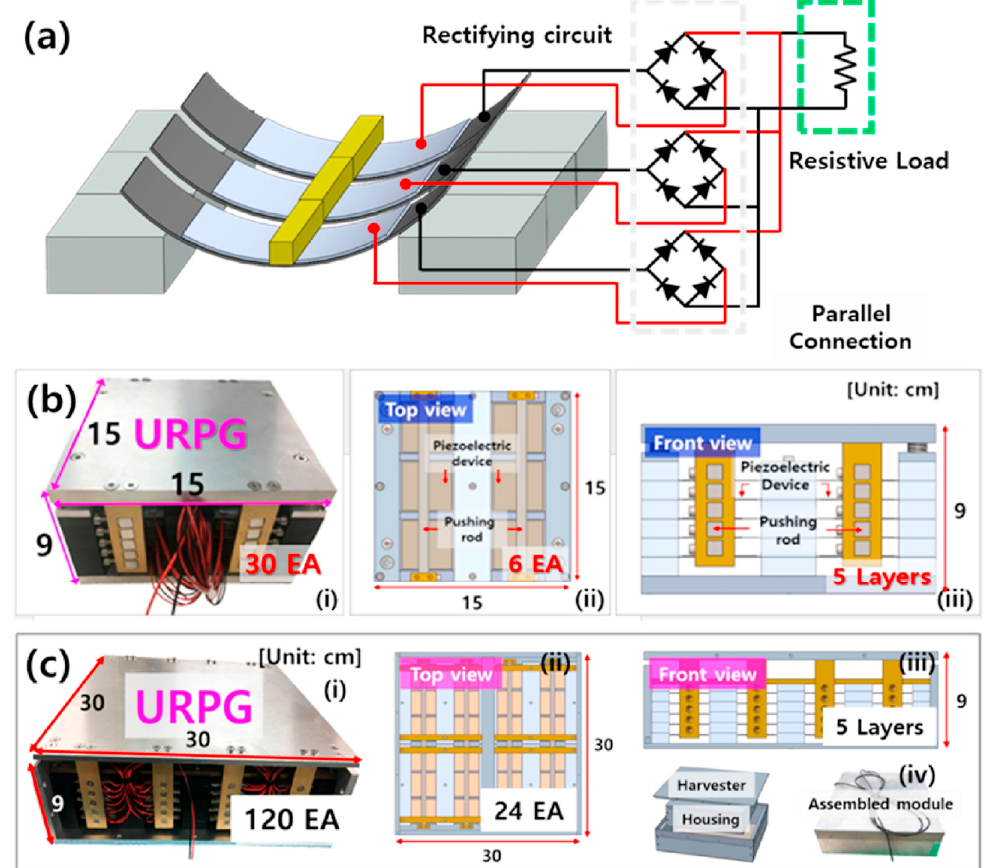
Figure 11. ( a ) Experimental setup using pushing tester for three piezoelectric devices. ( b ) The URPG (15 ∗ 15) using 30 open-type devices: (i) real photo view, (ii) top view, and (iii) front view. ( c ) The URPG (30 ∗ 30) using 120 open-type devices: (i) real view, (ii) top view, (iii) front view, and (iv) housing module and the assembled module. (Reprinted with permission from Ref. [36]. 2022, Elsevier)